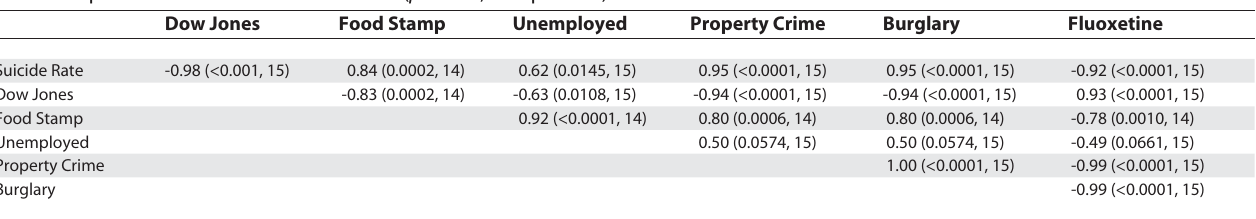
Table 2. Spearman Correlation Coeffi cients ( p -Value, Sample Size)